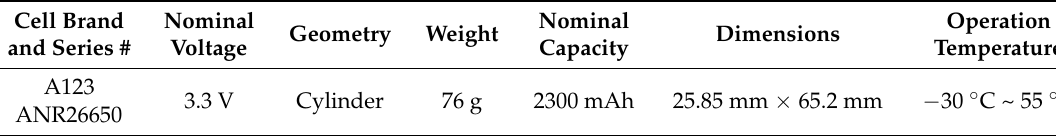
Table 2. Test parameters of the temperature cycling.